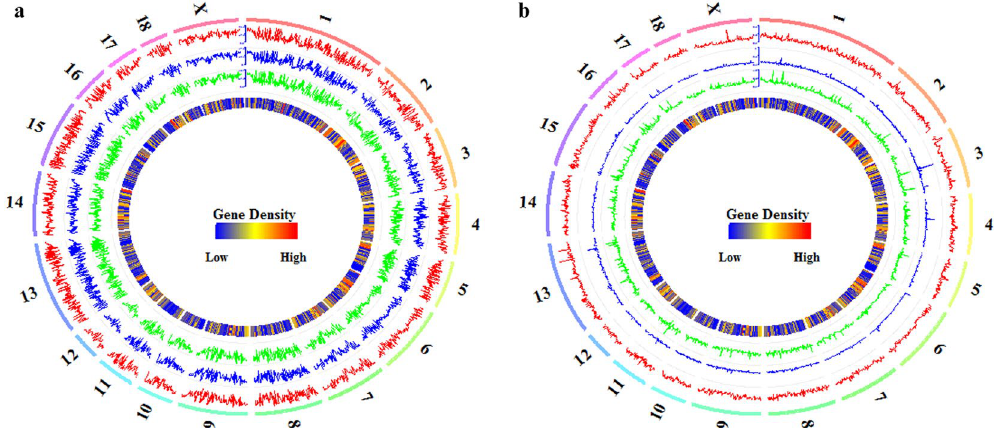
Figure 3. Global methylation of CpGs and CpHs and gene density. The global CpG ( a ) and CpH ( b ) methylation levels in the hypothalamus (track 1), pituitary (track 2) and ovary (track 3), from outside to inside, were quantified per 1 Mb window. The density of genes (track 4) was also quantified per 1 Mb window. The labels outside of track 1 represent the chromosomes of the porcine